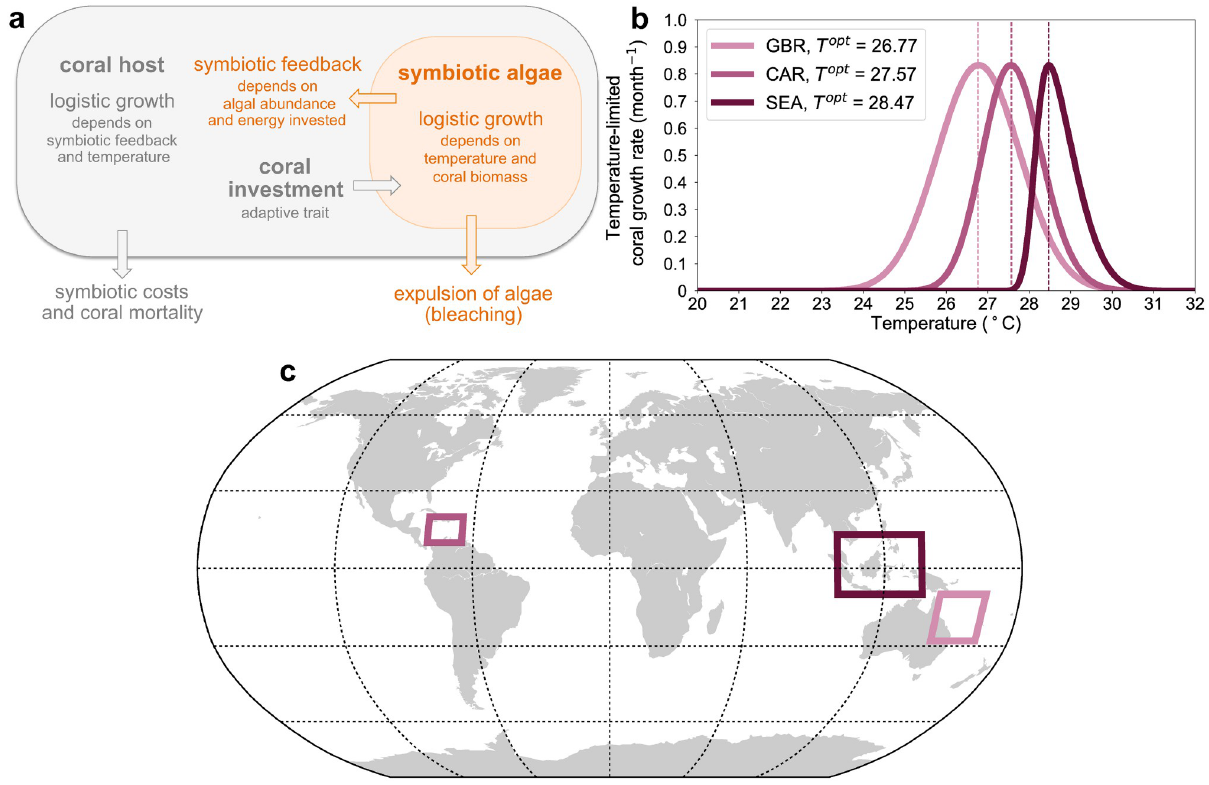
Fig 1. Model schematic and studied regions. (a) Schematic depicting the major interactions between the coral host and the symbiotic algae captured by the model; the coral host grows logistically as a function of symbiotic feedback and environmental temperature; corals invest energy in symbiosis (for example the energy necessary for providing CO 2 to the algae [34–36])and receives a symbiotic feedback (for example photosynthate); corals sustain symbiotic costs, which are associated to the maintenance of microenvironments for housing the algae [34] and to stress associated to photosynthesis (like the presence of reactive oxygen species [35]), and are subject to mortality; algae grow logistically as a function of environmental temperature and coral abundance; algae are expelled during bleaching events, which occur when environmental temperature exceeds the optimal regional temperature (i.e., T opt , panel b ) for coral growth by a variable range of temperature increase reflecting the severity of bleaching (see subsection Bleaching). (b) Temperature-limited coral growth curves (Eq 7); dashed lines mark the regional temperature optima. (c) Studied regions: Great Barrier Reef (GBR), South East Asia (SEA), and Caribbean (CAR). The map is produced with the Python’s Matplotlib Basemap Toolkit available from https://matplotlib. org/basemap/api/basemap_api.html ( © 2011, Jeffrey Whitaker).